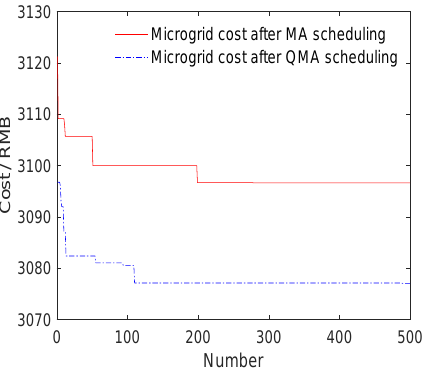
Figure 13. Microgrid operation cost utilizing regular scheduling